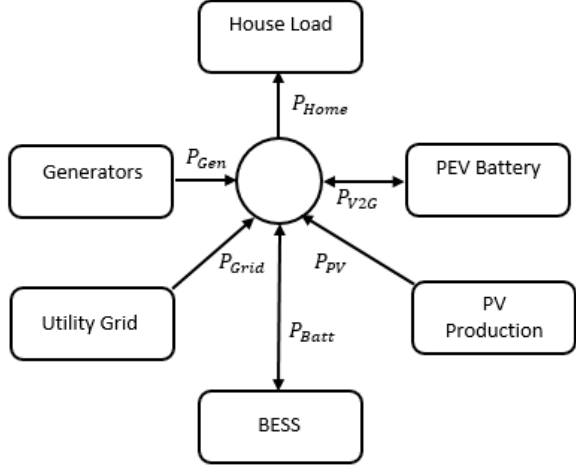
Figure 9. Power distribution with PEV, PV, and battery energy storage system (BESS) connected.